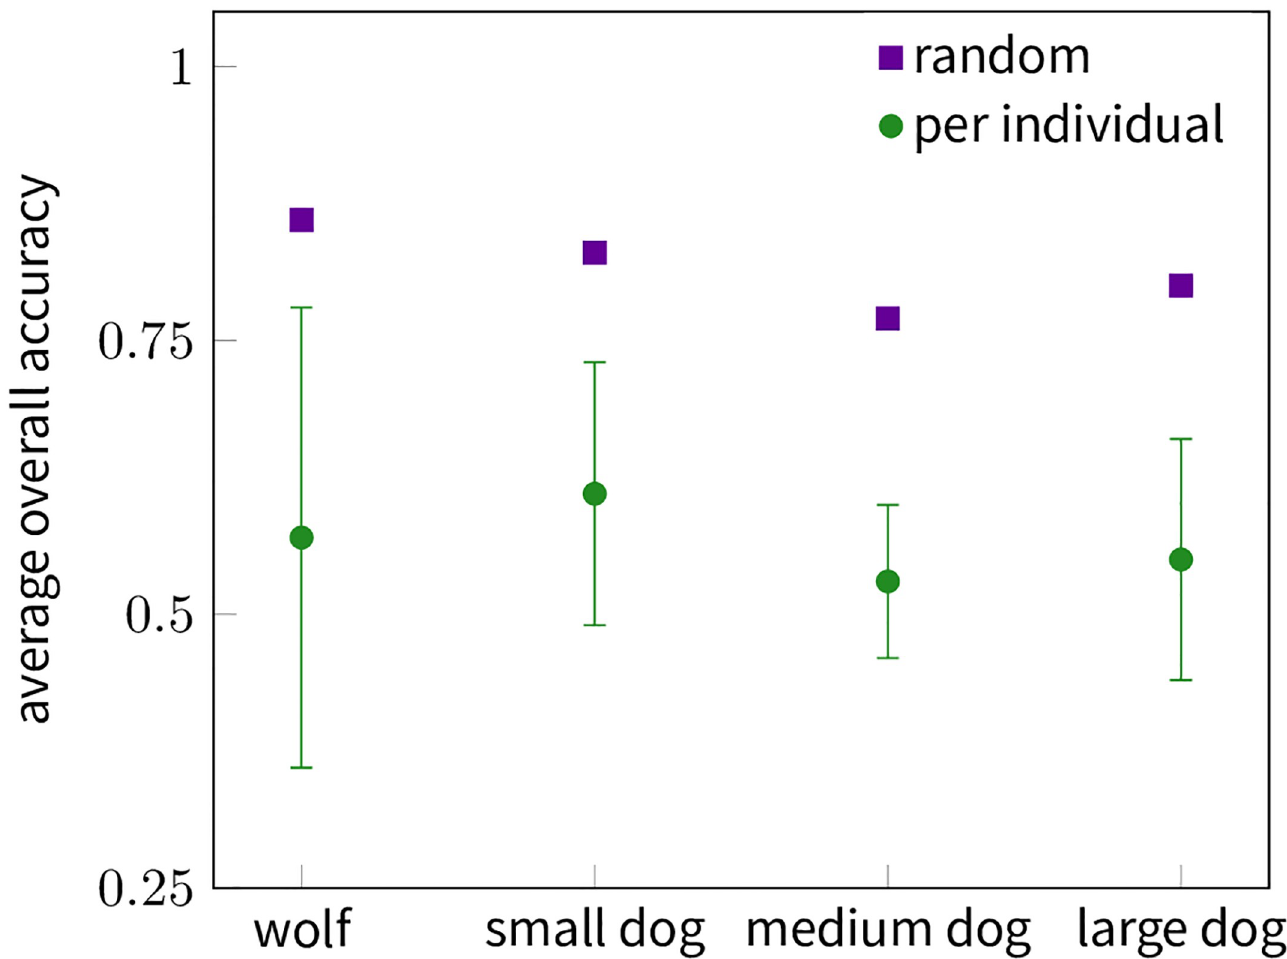
Fig 3. Overall accuracy of cross-validations with different strategies. In the “per individual” case, overall accuracies were calculated by using one animal as the test data and the other six animals to build the model. The figure shows the average of these 7 evaluation with a 95% confidence interval. In the “random” case 30% of the data was chosen randomly to serve as test data and the rest was used to build the model and the overall accuracy calculated. For fair comparison the figure presents the average of 7 such randomized tests (the confidence intervals are smaller than the markers). Due to the fact that in the randomized case a single animal is highly likely to contribute both to the training and the test data, much higher accuracies are reached, but using “per individual” gives a better estimate of the model’s performance when applied to specimens without labelled